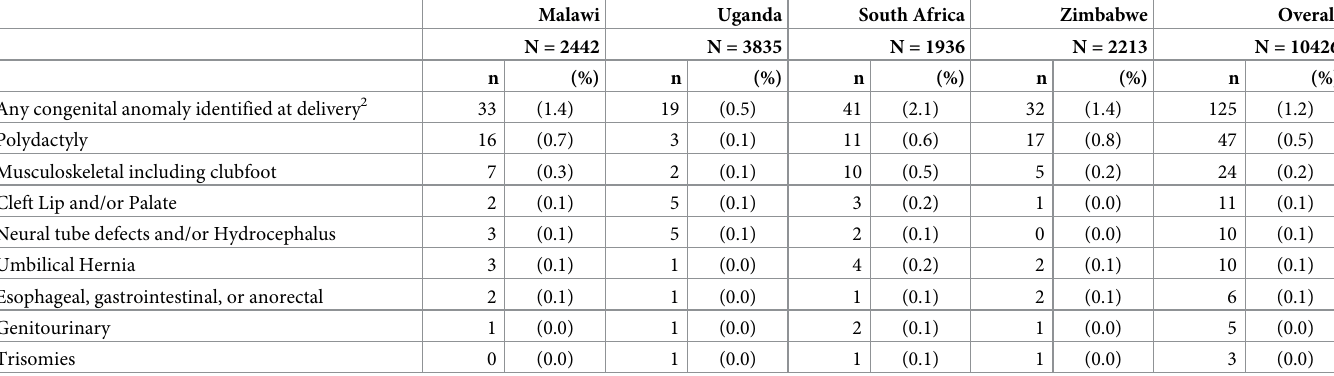
Table 5. Frequency of select suspected infant congenital anomalies identified at delivery 1